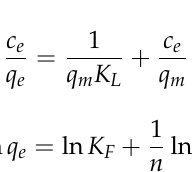
Table 2. Adsorption isotherm parameters for adsorption of tetracycline.